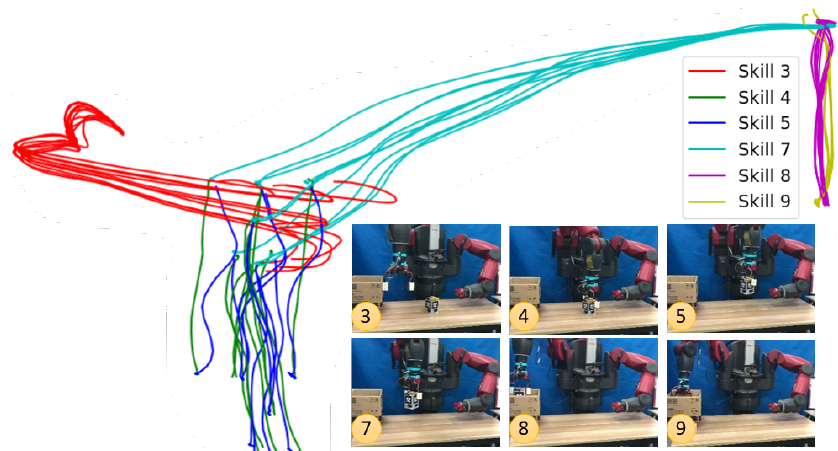
Figure 4. A kitting experiment consists of 6 skills (in various colors) that were modeled by DMP, respectively. Objects that need to be packaged are placed by a human collaborator before the robot in a collection bin. The shared workspace affords possibilities for accidental contact and unexpected alteration of the environment. The robot is tasked to pick each one of the objects and place them in the packaging box to its right. The visualization module uses the ALVAR tags to provide a consistent global pose with respect to the base of the robot. Ten nominal executions and one snapshot of each skill are